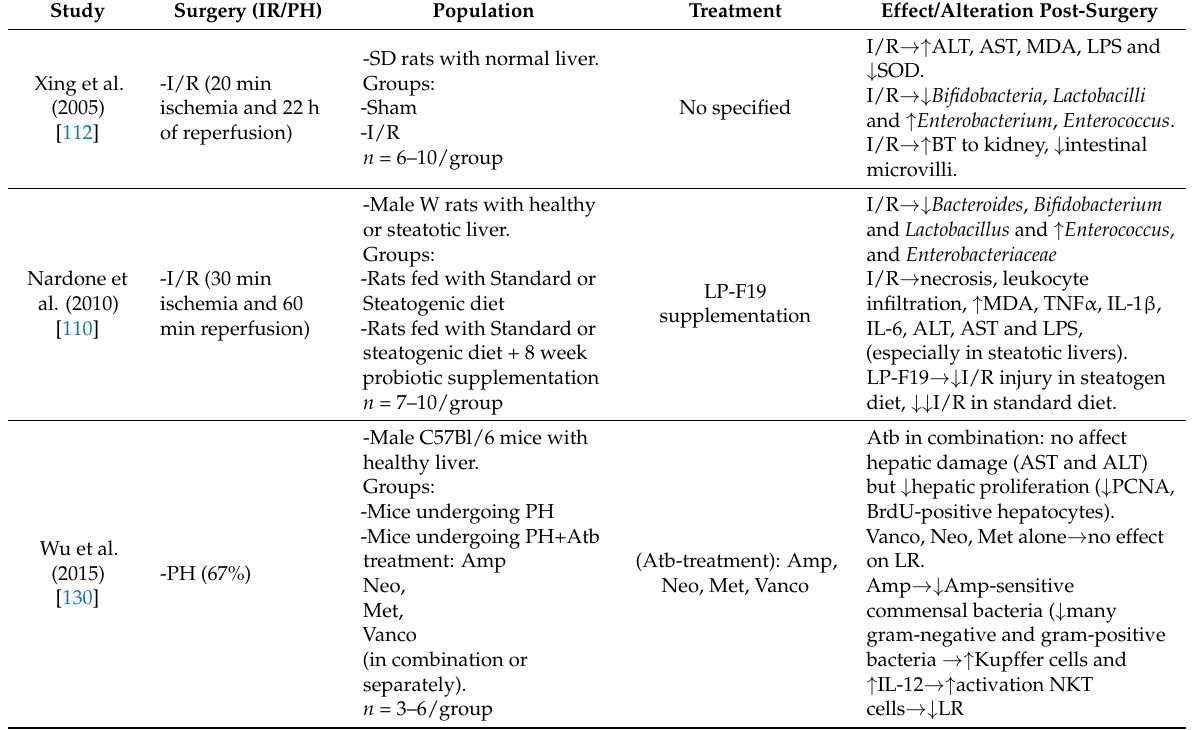
Table 3. Preclinical studies in partial hepatectomy